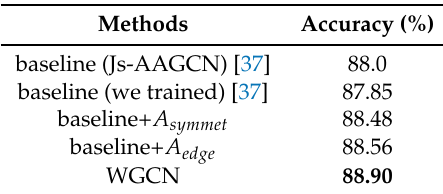
Table 1. Comparison of the recognition accuracy of WGCN with or without the symmetric connection and edge connection on the NTU RGB+D 60 cross-subject (X-Sub) dataset. The best result is shown in bold.